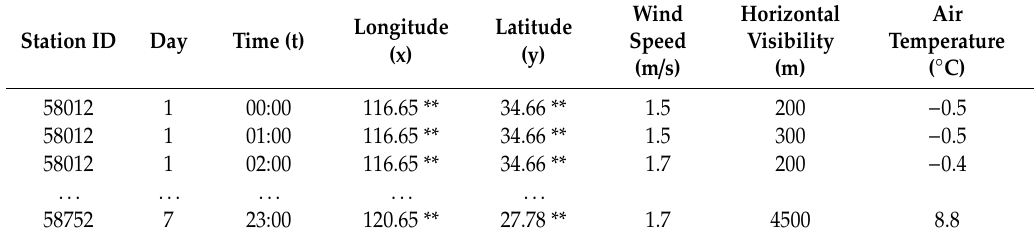
Table 3. Instance of ground-station meteorological